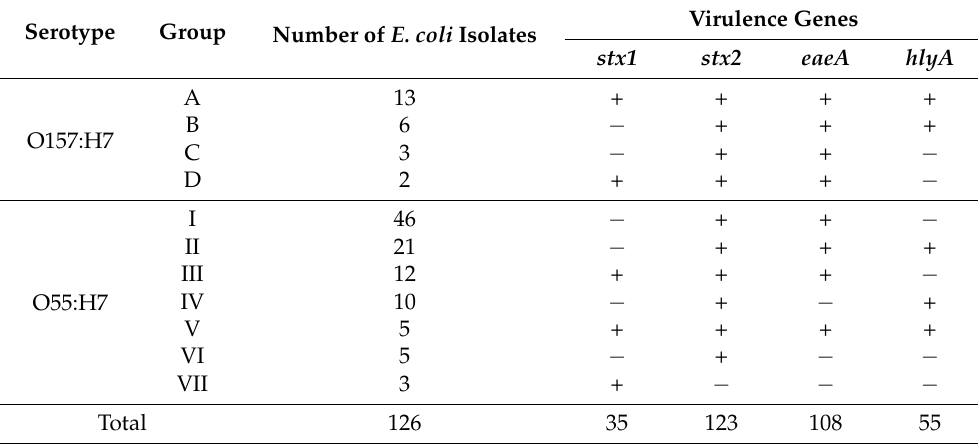
Table 1. Distribution of virulence genes among the obtained E. coli O157:H7 and O55:H7 isolates ( n =